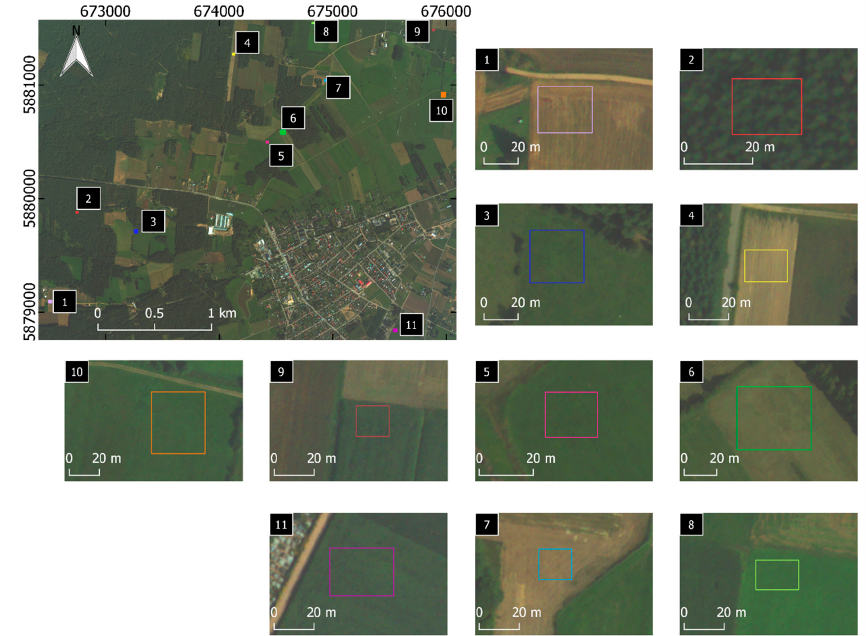
Figure A1. Locations of samples used for the study (1, 4, and 7—bare soils; 2—forest; 3,5,8, and 10—meadows; 6—mowed meadow; 9 and 11—farmlands).